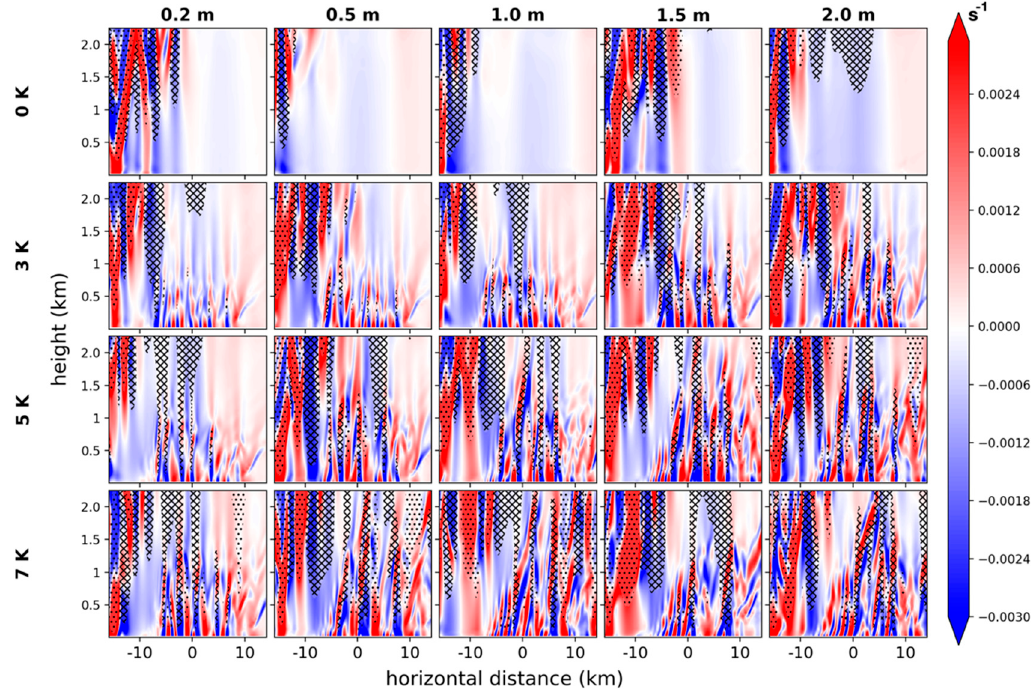
Figure 8. Divergence (colored) and vertical velocity (hatched contours are areas greater than 1 m s − 1 and stippled areas are areas less than − 1 m s − 1 ) at t = 145 min. Negative values indicate convergence.